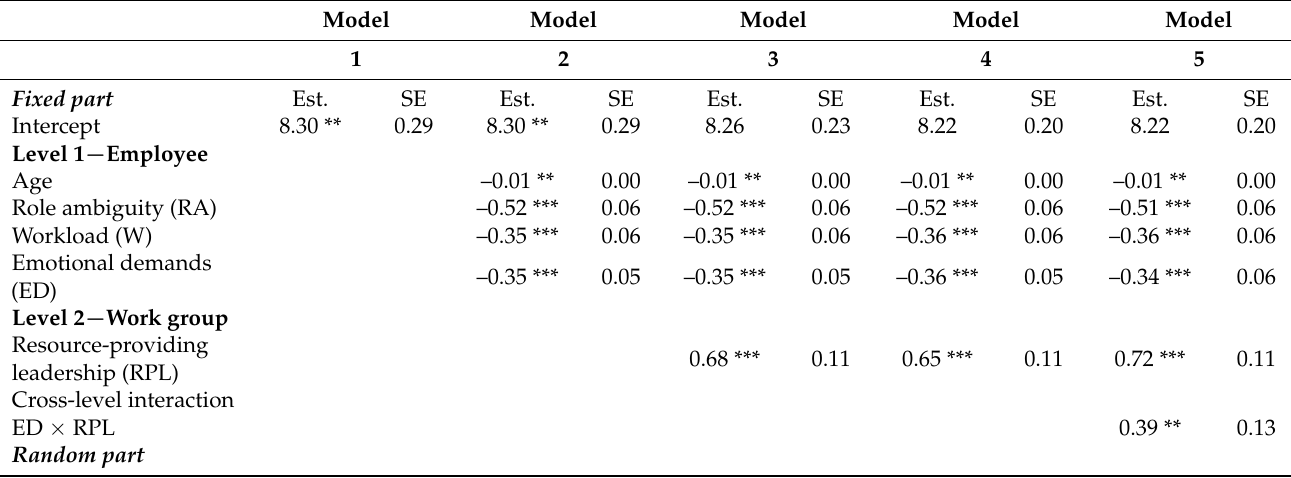
Table 2. Multilevel analysis predicting work ability from job demands (Level 1) and resource-providing leadership (Level 2), controlling for country-level variance (Level